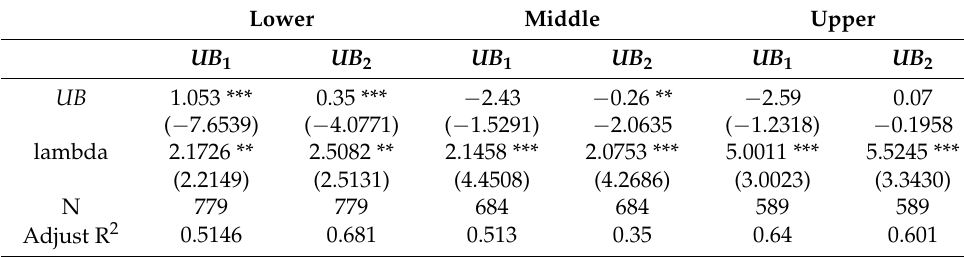
Table 6. Spatial heterogeneity regression. Lower Middle